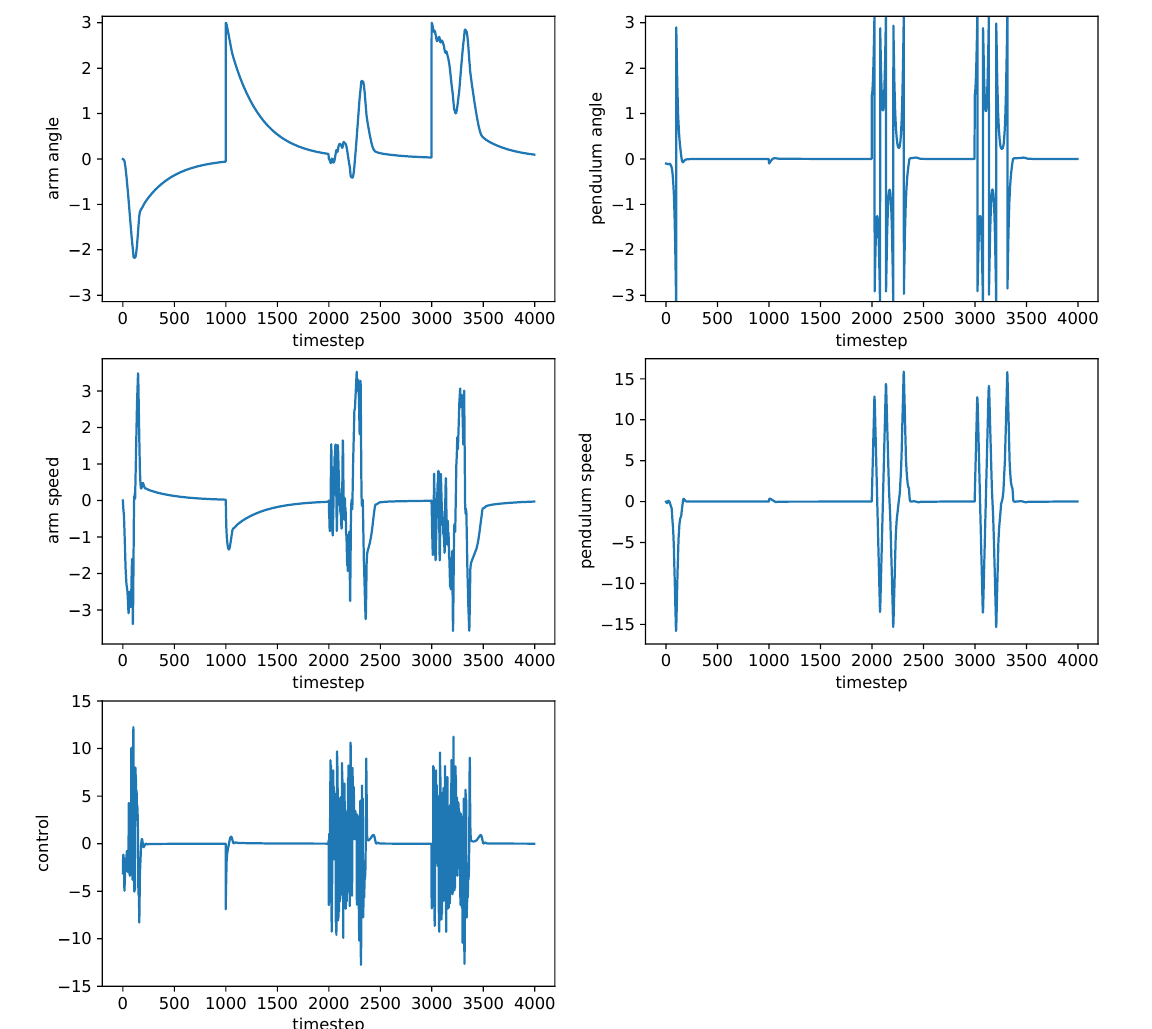
Figure 7. Pendulum dynamics with controller designed by neuroevolution without DBM.